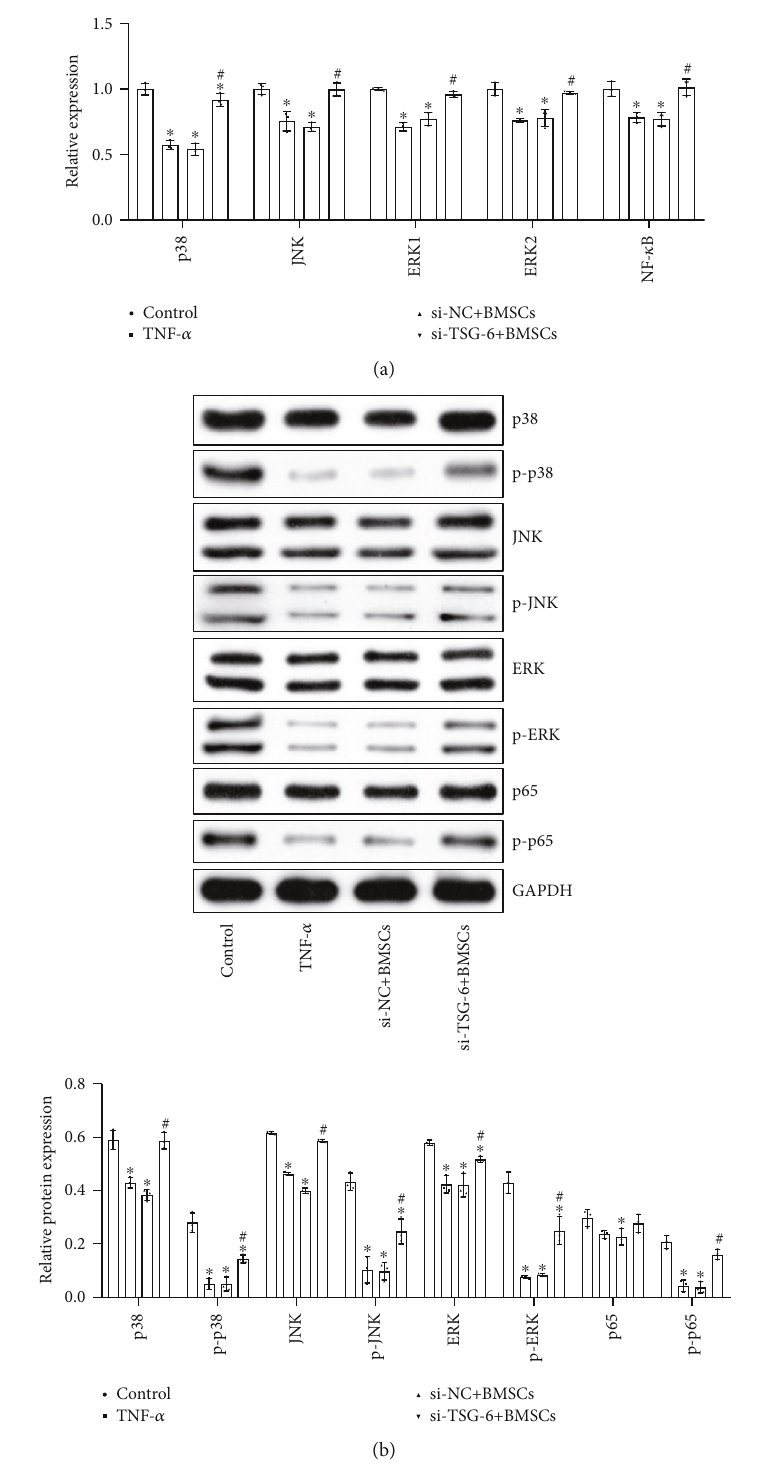
Figure 3: TSG-6 secreted by BMSCs inhibited the activation of the NF- κ B/MAPK signaling pathway. (a) qRT-PCR measured the expression of the NF- κ B/MAPK signaling pathway. (b) Western blot observed the protein expression of the NF- κ B/MAPK signaling pathway. BMSCs (medium containing BMSCs (TNF- α activation group)), si − NC + BMSCs (medium containing BMSCs (NC siRNA + TNF − α activation group)), and si − TSG − 6 + BMSCs (medium containing BMSCs ( siRNA − TSG − 6 + TNF − α activation group)). ∗ Compared with the control group, P < 0 : 05 ; # compared with the si − NC + BMSC group, P < 0 : 05 . The above experimental results were all measurement data. Data were expressed as the mean ± SD . One-way ANOVA and Tukey ’ s test were used only for the data comparison between multiple